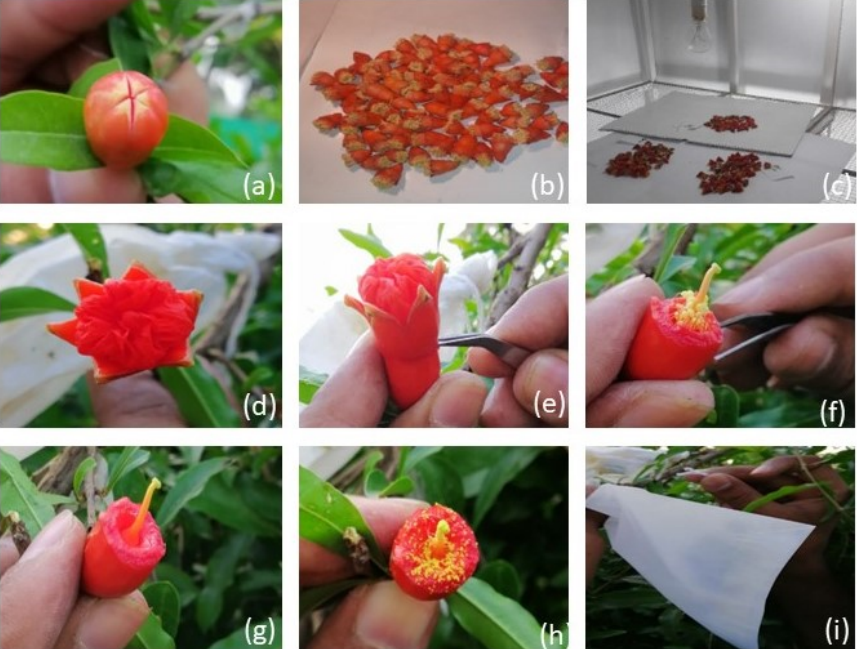
Figure 7. Crossing procedure in pomegranate genotypes. ( a ) bud at balloon stage ( b ) flower buds after removal of sepals, petals, stigma, and style ( c ) flower buds kept under lamp for dehiscence of pollens ( d ) flower bud at close petal stage ( e , f , g ) emasculation ( h ) pollen dusting ( i ) bagging and tagging.